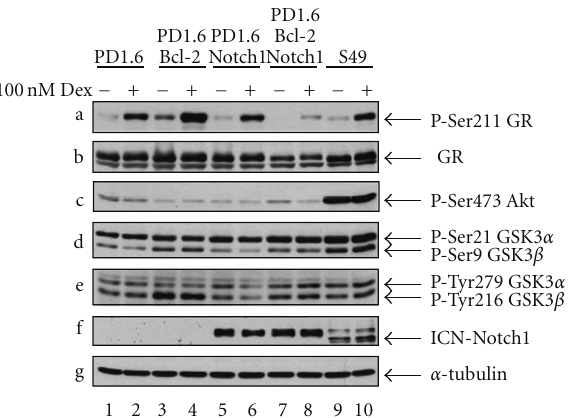
Figure 3: PD1.6Bcl-2Notch1 cells show reduced GR expression. Western blot analysis of untreated or Dex-treated (100 nM, 2 hrs) cells. α -Tubulin was used as loading